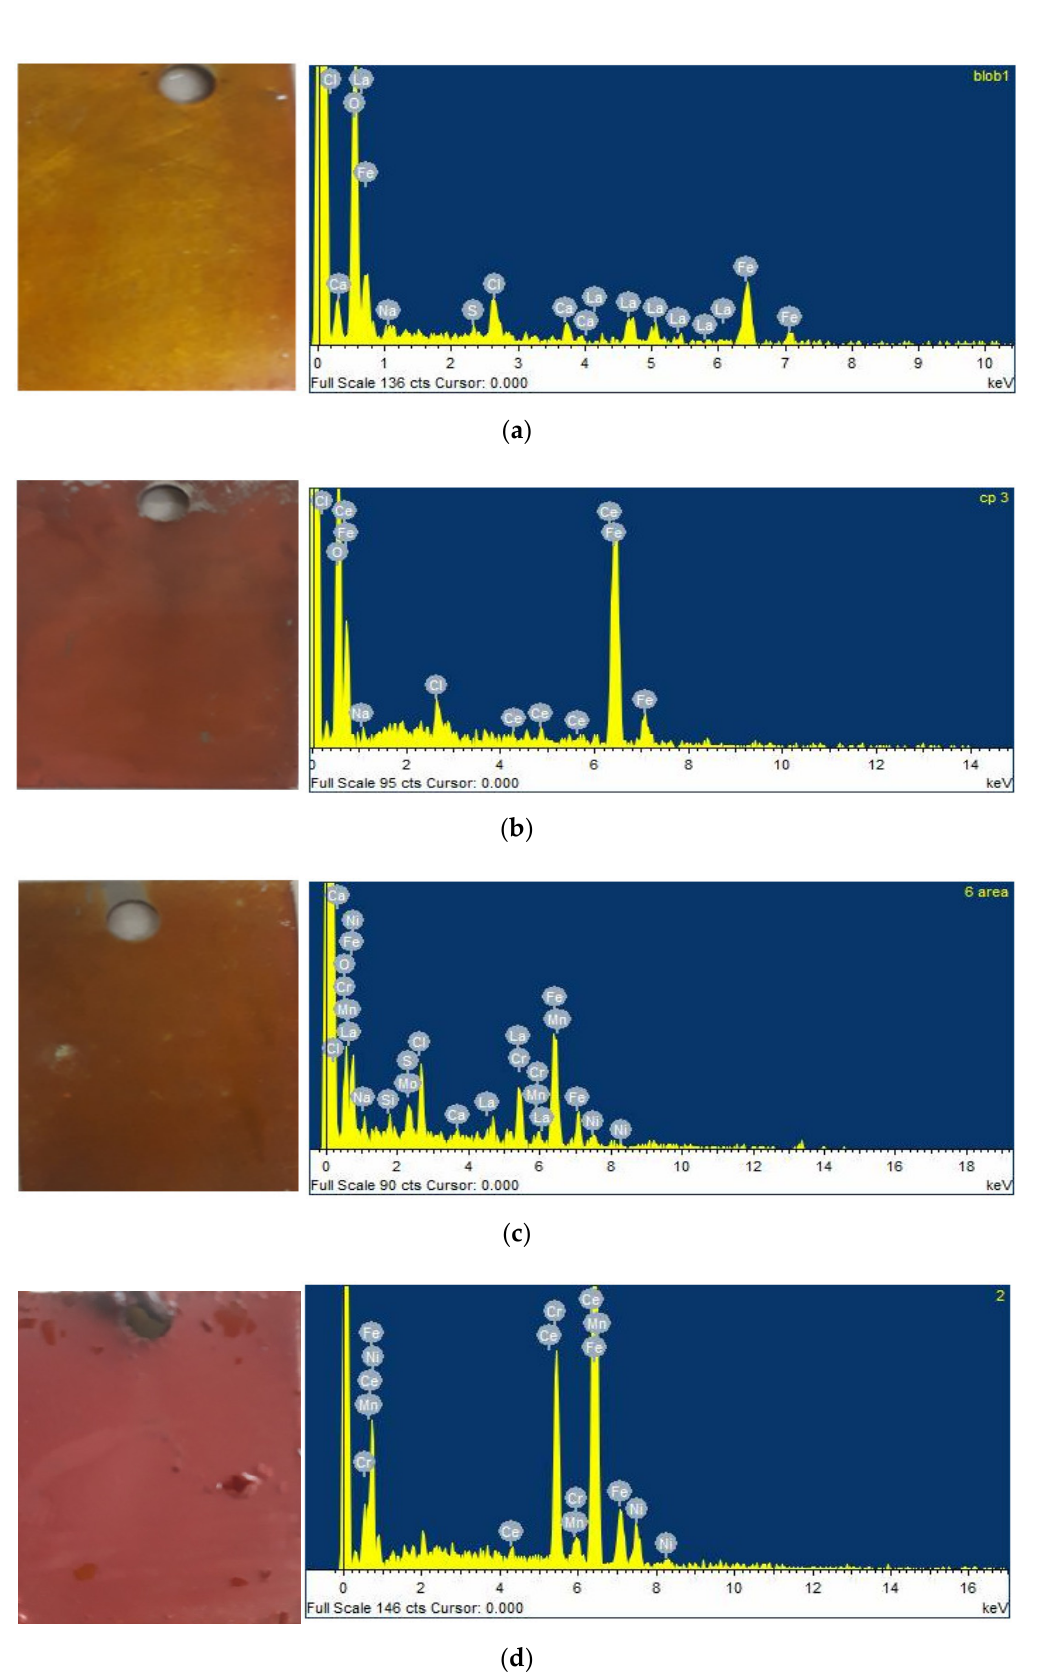
Figure 2. EDX spectra of ( a ) and ( b ) MS coupon exposed to 3.5% NaCl solution containing La ( acac ) and Ce ( acac ) , ( c , d ) 304 SS inhibited with La ( hfac ) Ce(acac) (cid:5) 3